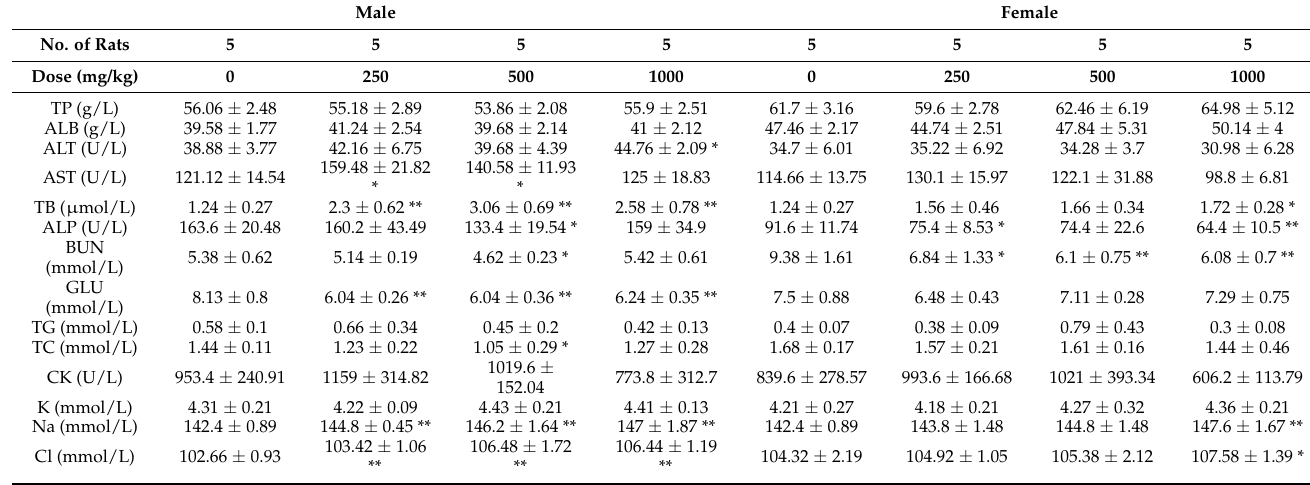
Table 3. Clinical biochemistry of male and female rats fed with 0, 250, 500, and 1000 mg/kg b.w./day curcumol for 28 days. Values are mean ± SD for five